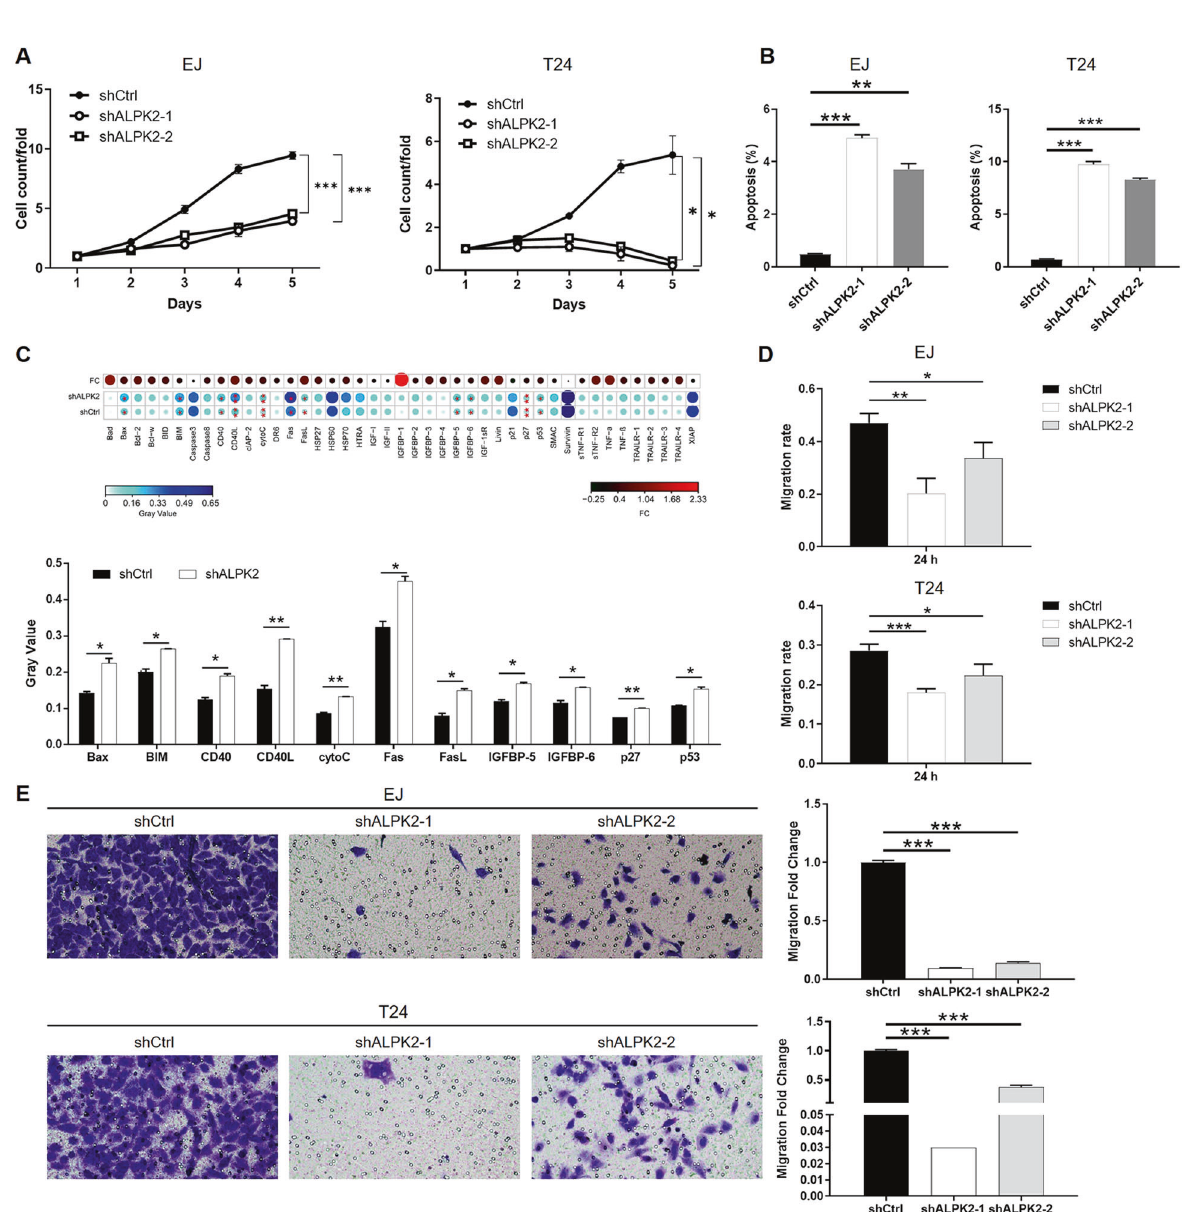
Fig. 2 ALPK2 knockdown inhibited bladder cancer development in vitro. A Celigo cell counting assay was employed to show the effects of ALPK2 on cell proliferation of EJ and T24 cells. B Flow cytometry was performed to detect cell apoptosis of EJ and T24 cells with or without ALPK2 knockdown. C Human apoptosis antibody array was utilized to analyze the regulatory ability of ALPK2 on expression of apoptosis- related proteins in T24 cells. D , E The effects of ALPK2 on cell migration ability of EJ and T24 cells were evaluated by wound-healing assay ( D ) and Transwell assay ( E ). The representative images were selected from at least three independent experiments. Data were shown as mean ± SD. * P < 0.05, ** P < 0.01, *** P < database further established a signi fi cant correlation between high expression levels of ALPK2 and more advanced T stage, N stage, and pathological stage, in bladder cancer patients (Fig. 1B – D and Tables S3 and S4); these fi ndings were con fi rmed by our own results, at